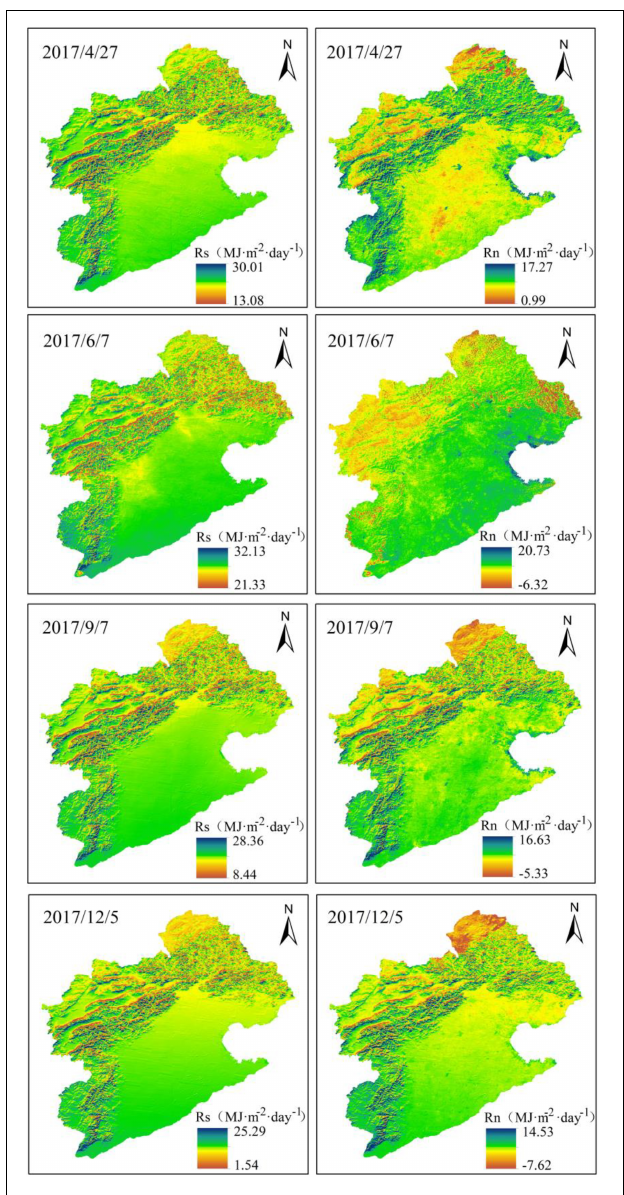
FIGURE 9 | Spatial heterogeneity of the daily solar incident radiation (Rs) and the surface net radiation (Rn) in Haihe River Basin.